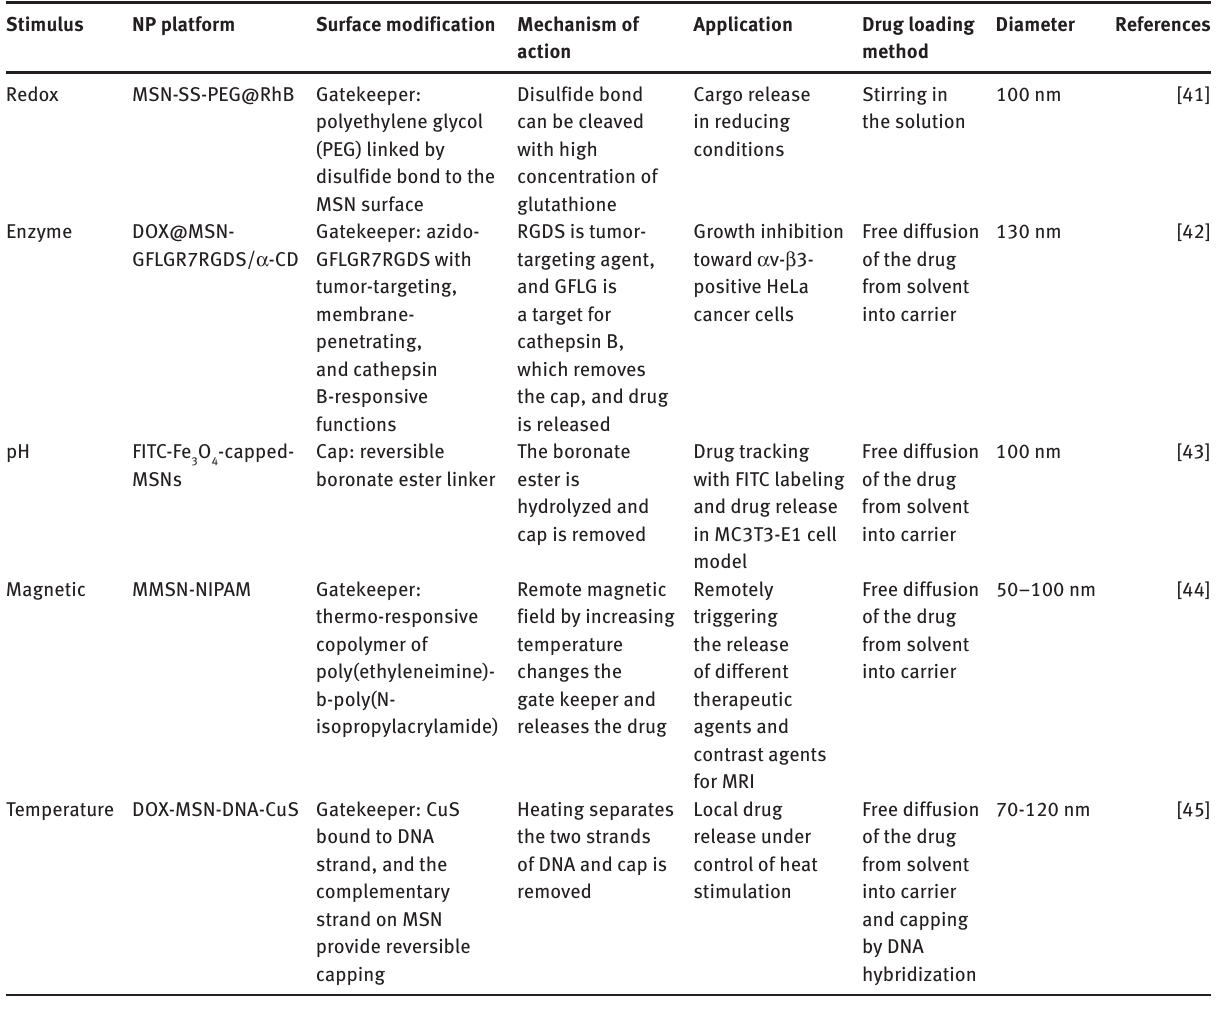
Table 1: Examples of stimuli-responsive MSN and some selected properties. Stimulus